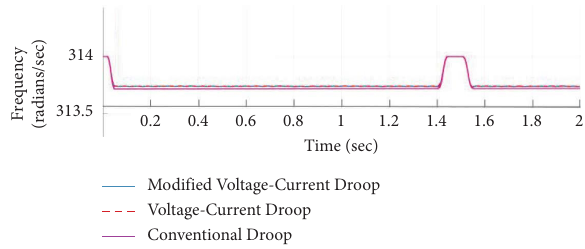
Figure 22: Frequency during contingency